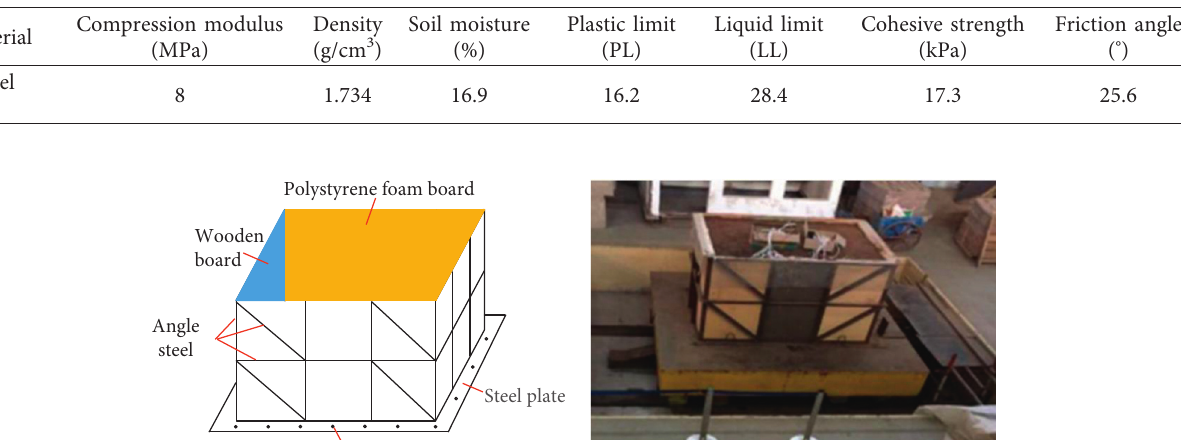
Table 4: Parameters of model soil.